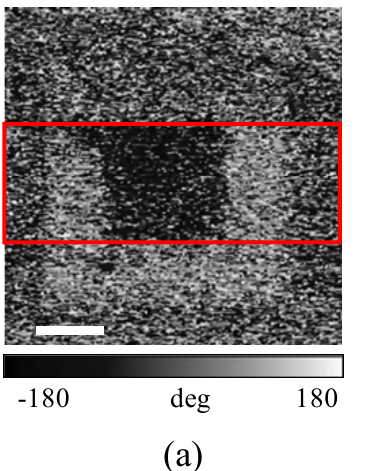
Figure 11. (a) Non-linear dielectric constant microscope phase image taken at room /BiCrO artificial superlattice grown on SrTiO temperature of 6-monolayer BiFeO 3 3 3 (1 1 1) substrate. The white scale bar indicates 600 nm. The image was taken after applying 10V in the outer square area (2  2  m 2 ) and then − 10 V in the center square area (1  1  m 2 ). (b) Phase shift of the image obtained by averaging the data in the rectangle area surrounded by red lines in (a). The result shows that the ferroelectric polarization /BiCrO thin film can be switched by the domains in the artificial superlattice BiFeO 3 3 applied